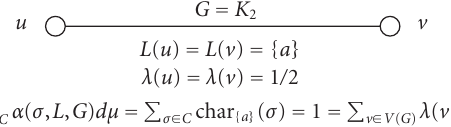
Figure 4.1. Hall’s condition satisfied by K 2 , L , λ , but no proper coloring is